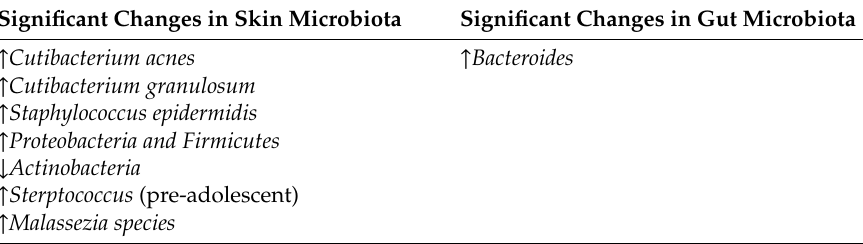
Table 3. Skin and gut microbiota of acne patients compared with healthy